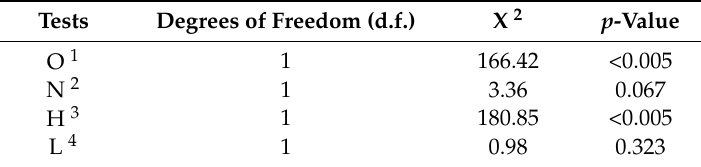
Table 6. Results and statistical significance of chi-squared